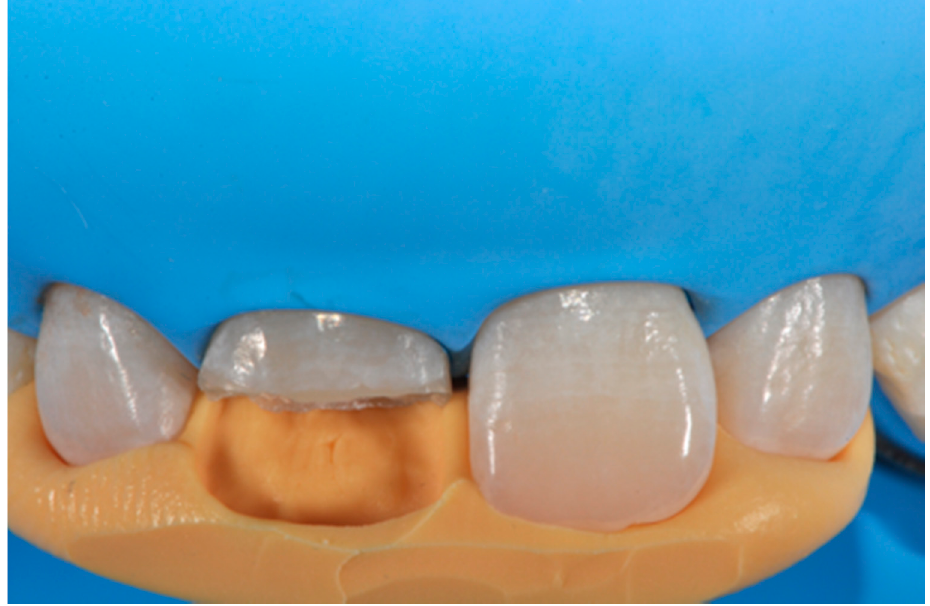
Figure 4. Silicone index try-in after rubber dam isolation. Reprinted from Restauri diretti nei settori anteriori, G. Paolone, S. Scolavino, © 2021, with permission from Quintessence Publishing Italy.